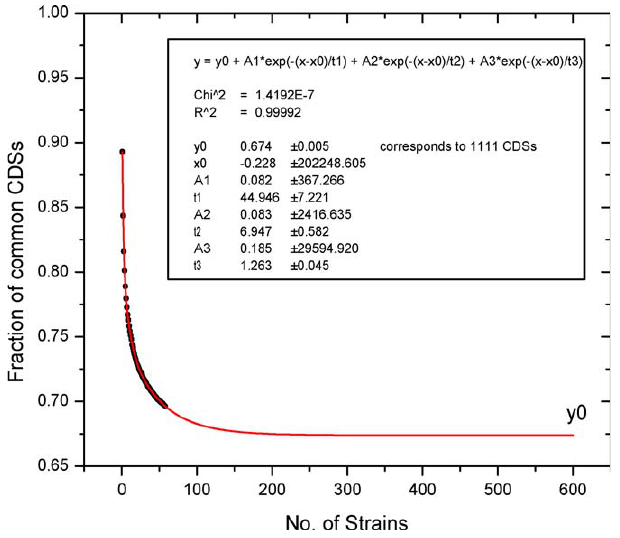
Figure 2. Extrapolated Number of Universally Present CDSs in H. pylori The fraction of CDSs present in a sample of strains ( ‘‘ common CDSs ’’ ) was calculated on random samples of one to 56 strains taken without replacement. Mean fractions of common CDSs were calculated from 100 iterations of this sampling procedure. The graph shows the results of fitting an exponential decay model to these calculations, in which y0 approaches the minimum number of universally common CDSs at infinity (0.674 3 1,649 CDSs ¼ 1,111 universally present CDSs). DOI: 10.1371/journal.pgen.0010043.g002